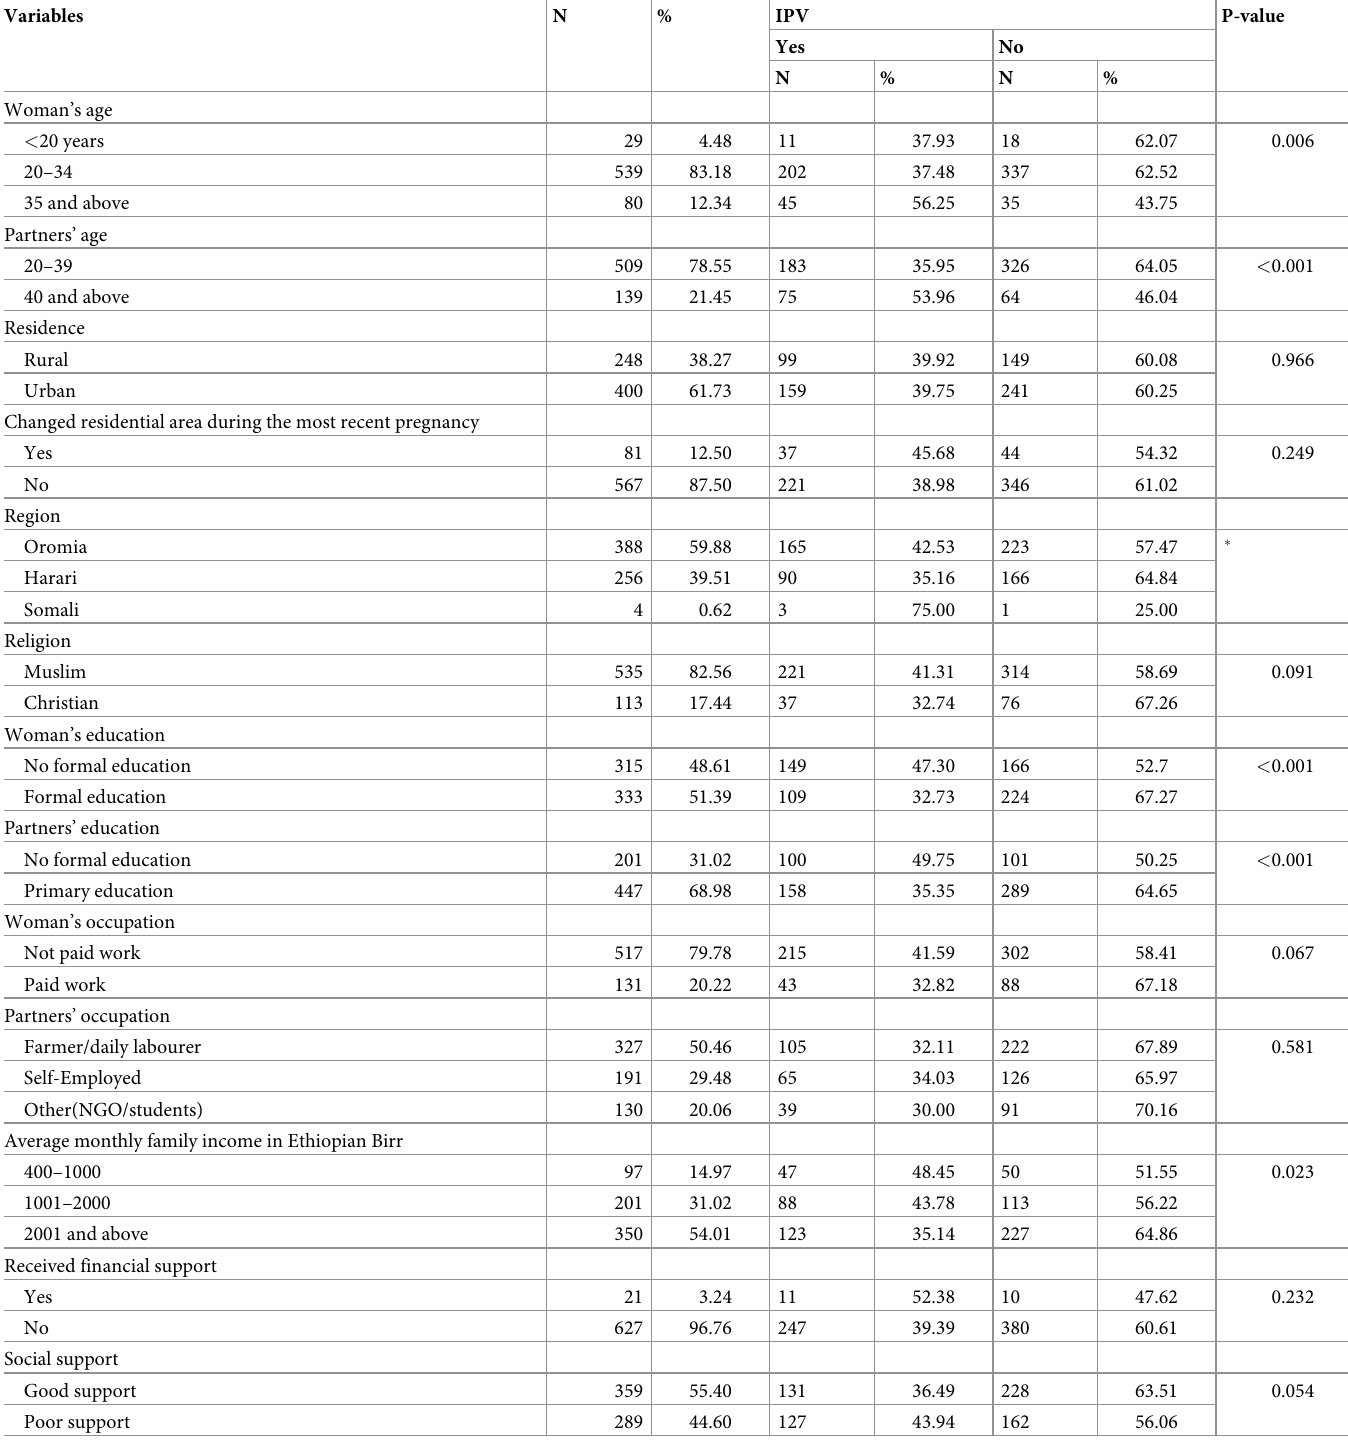
Table 2. Socio-demographic characteristics of women who gave birth in public hospitals in Harari regional state, East Ethiopia, 2018–2019.